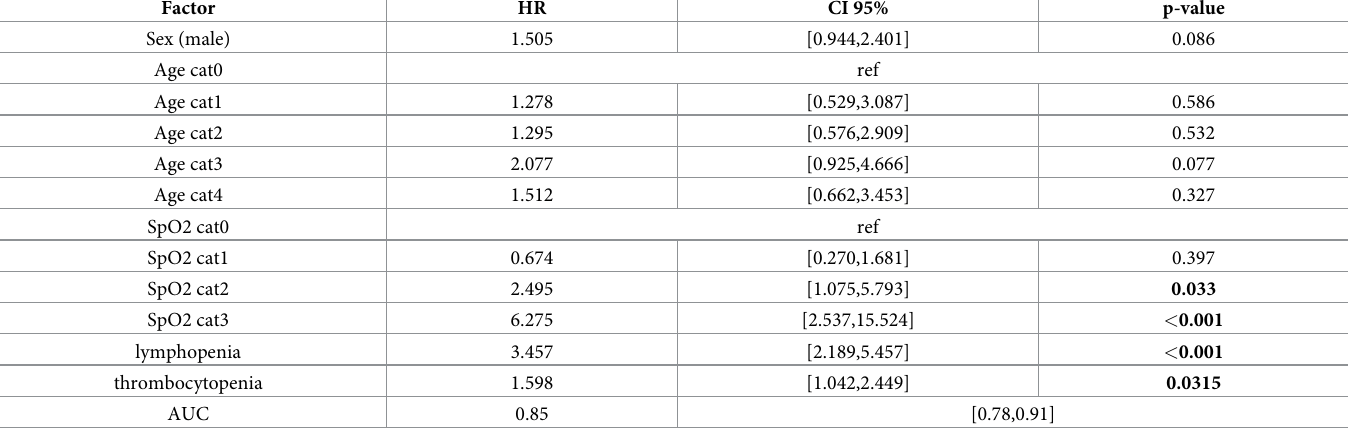
The Cox Proportional-Hazards Model was used for PCEP (Table 2). Age was categorized based on the Petrilli et al. study [27], and the reference category was set to 0–44 years old. The normal range of oxygen saturation (95%-100%) was set as the reference category in SpO2. The developed survival model showed very good diagnostic accuracy (AUC = 0.85) for discrimi- nating COVID-19 patients with/without PECP. Among 456 COVID-19 patients discharged from the hospital, three patients died during the first follow up (i.e., the first week) while one more patient died at the second follow up (the fourth week). Those patients who died were from the PCEP group. The clinical symptoms of the patients during four weeks of follow up are shown in Table 3. Table 2. The Cox Proportional-Hazards Model for PCEP.